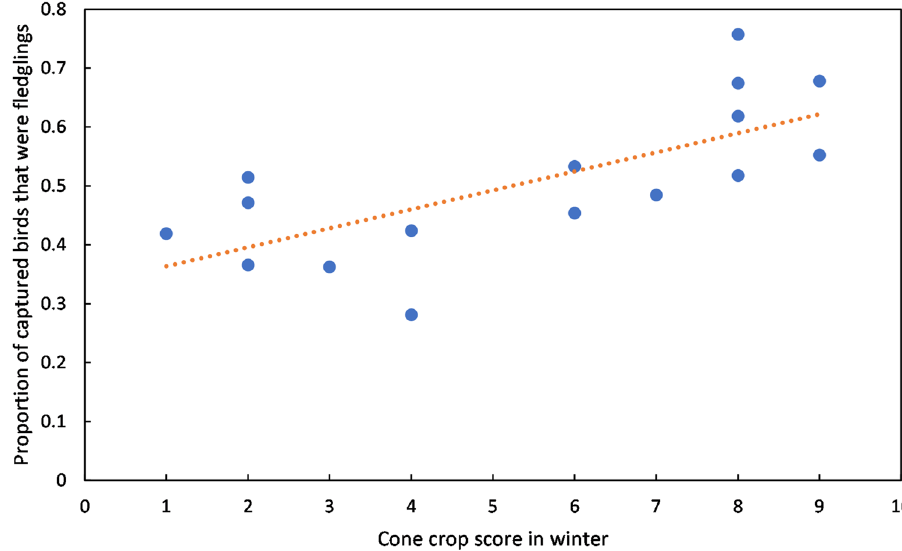
Figure 6. Fledgling abundance by year. Proportion of all captured siskins in June and July identified as fledglings in each year (2005–2020). R 2 = 0.5082.